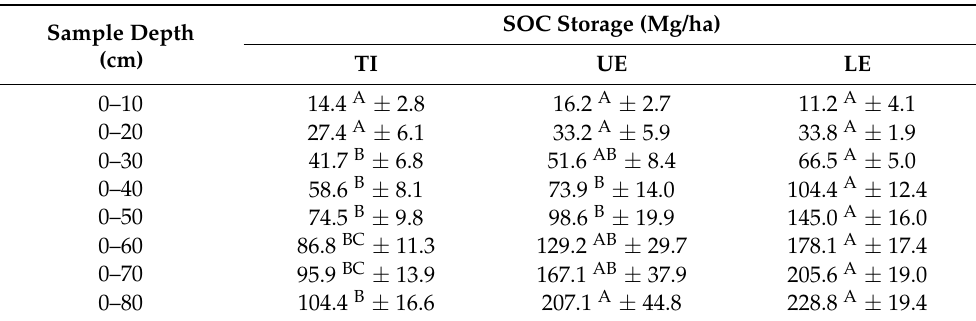
Table 2. SOC storage of various soil depth in different geomorphologic settings (mean ± standard errors, n = 3).